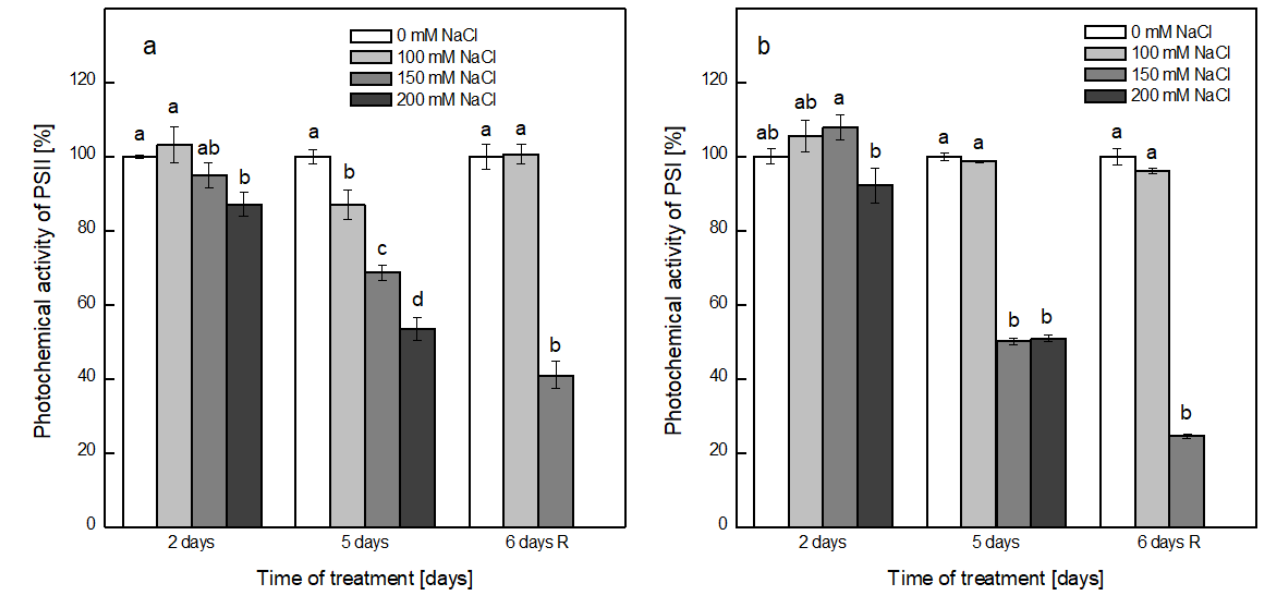
Figure 5. Salt-induced changes in the photochemical activity of PSII ( a ) and PSI ( b ) in isolated thylakoid membranes from the non-treated plants, plants treated for 2 and 5 days with 0, 100, 150 and 200 mM NaCl and recovered pea plants after 6 days (6 days R). Results are presented as the percent of the respective control (0 mM NaCl). Measurements were performed in the presence of exogenous electron donors and acceptors, as described in the Materials and Methods. Results are presented as mean values ± SE, calculated based on three independent experiments with three parallel samples for every time point ( n = 9): 100% for PSII—36.93 ± 0.18 µmol O 2 mg Chl − 1 h − 1 and for PSI—267.55 ± 5.54 µmol O 2 mg Chl − 1 h − 1 . Different letters indicate significant differences between values for the control plants (0 mM NaCl) and plants treated with increased concentrations of NaCl at p < 0.05 for the respective period of the experimental setup (2 and 5 days of treatment and after recovery (6 days R)).